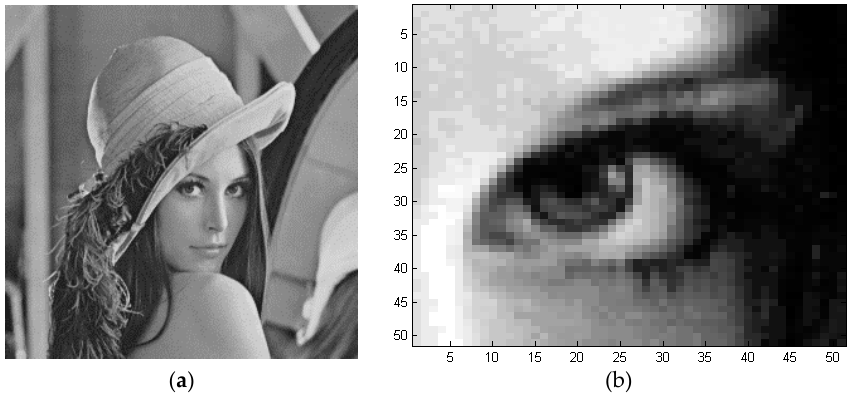
Figure 10. Grey intensity image: ( a ) Lena Image; ( b ) A sub-image zoomed in the eye area of 51 × 51 pixels 2 .